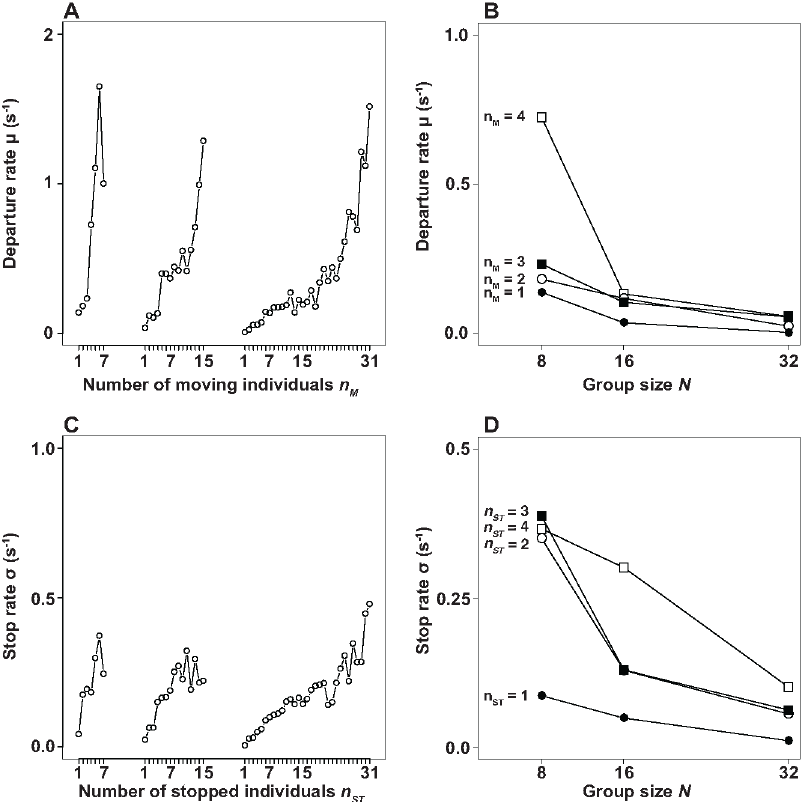
Fig 2. Individual transition rates. (A) and (C) show that the departure and stop rate increase with n M and , respectively, for all group sizes (N = 8, 16 and 32). (B) The inhibiting effect of S S on the transition S S ! M n S T for a given n M is evidenced by the decrease of the transition rate with N. (D) Similarly, in the transition M ! S T , we observe a decrease of the transition rate with N for a fixed value of n S role of n M